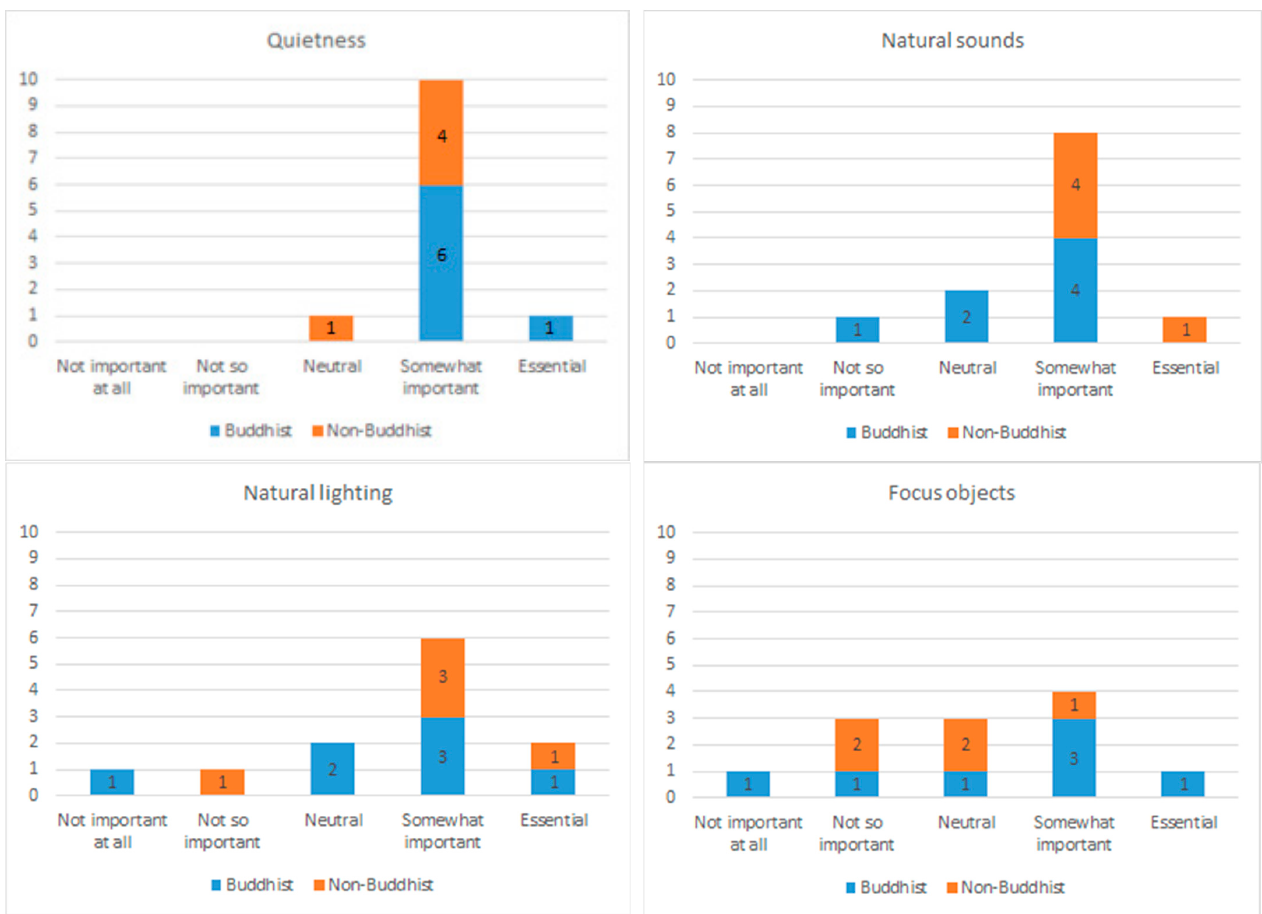
Figure 8. Influence of the environment. (Question: At this moment in time, please rate whether the following physical elements have a positive, negative or neutral influence on your mindfulness meditation practice, where –5 = very negative influence, 0 = neutral, and +5 = very positive influence. If the element is not present in the space where you practice the most, please select N/A .)